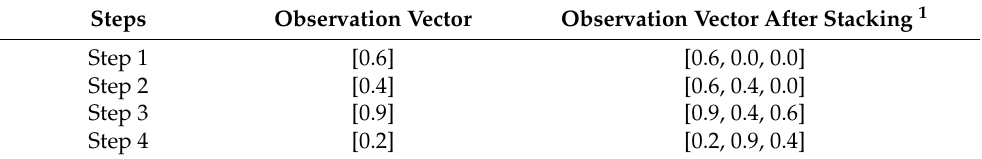
Table 4. Effect of